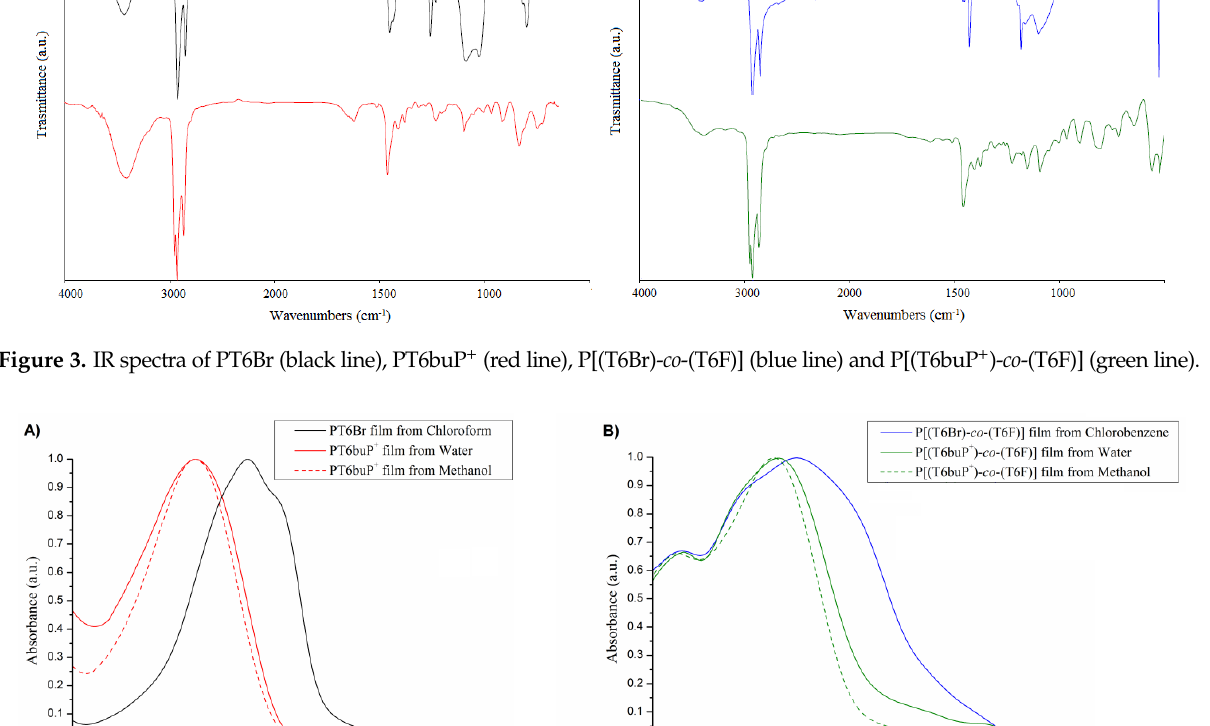
Figure 3. IR spectra of PT6Br (black line), PT6buP + (red line), P[(T6Br)- co -(T6F)] (blue line) and P[(T6buP + )- co -(T6F)] (green line).